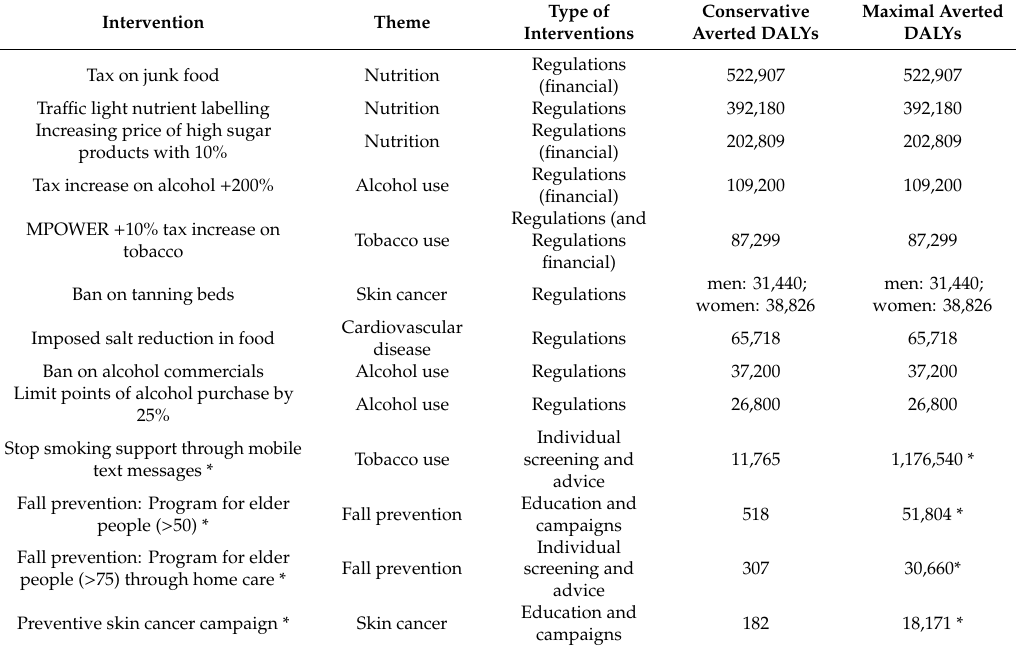
Table 2. Ranking of 13 cost saving interventions, based on conservative averted DALYs (CAD) (ranked from highest CAD to lowest CAD).